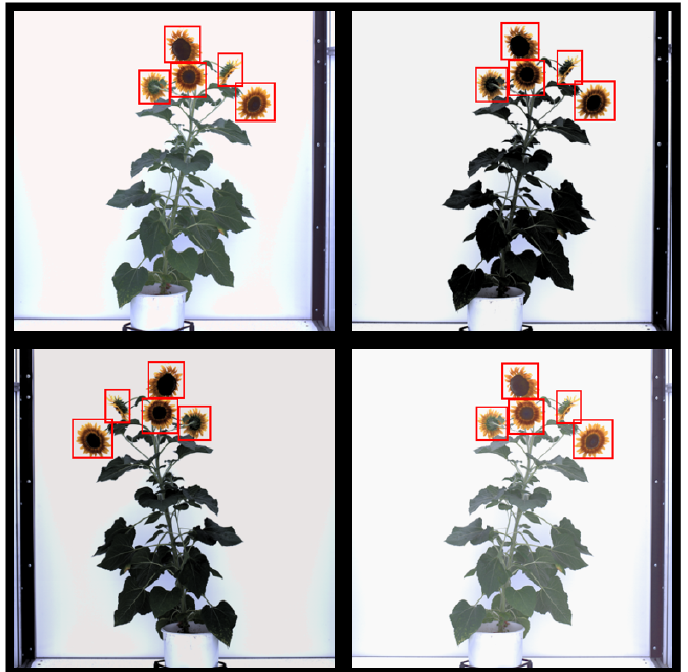
Figure 4. Illustration of data augmentation strategies using transformations and illumination alter- ation: original image ( top-left ); scaled image ( top-right ); reflected image ( bottom-left ) and illumina- tion altered image ( bottom-right